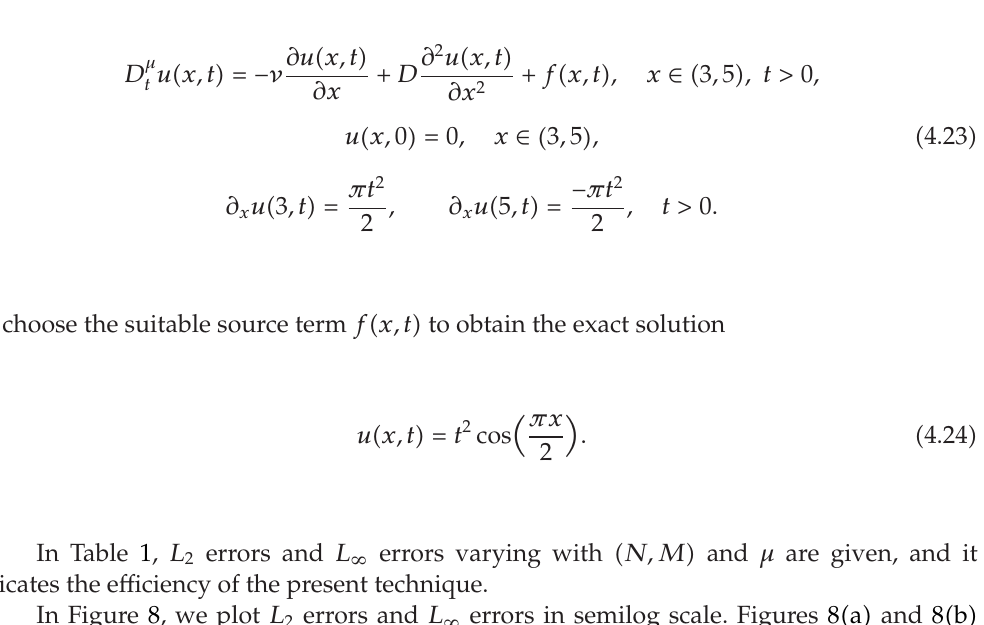
In Table 1, L 2 errors and L ∞ errors varying with (cid:4) N, M (cid:5) and μ are given, and